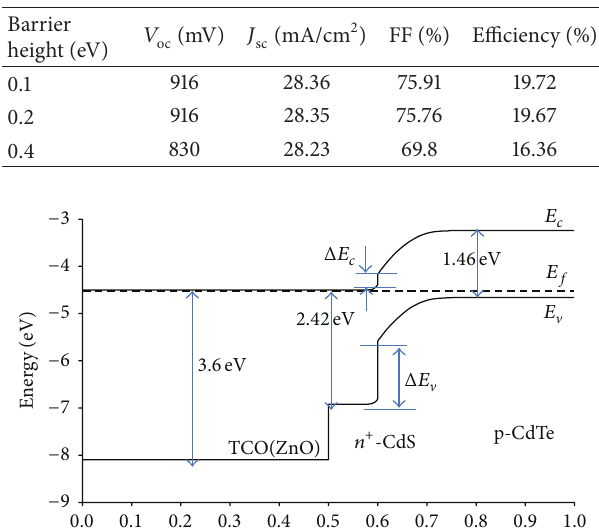
Table 2: Current-voltage characteristics of a CdTe cell with different Schottky barrier heights.